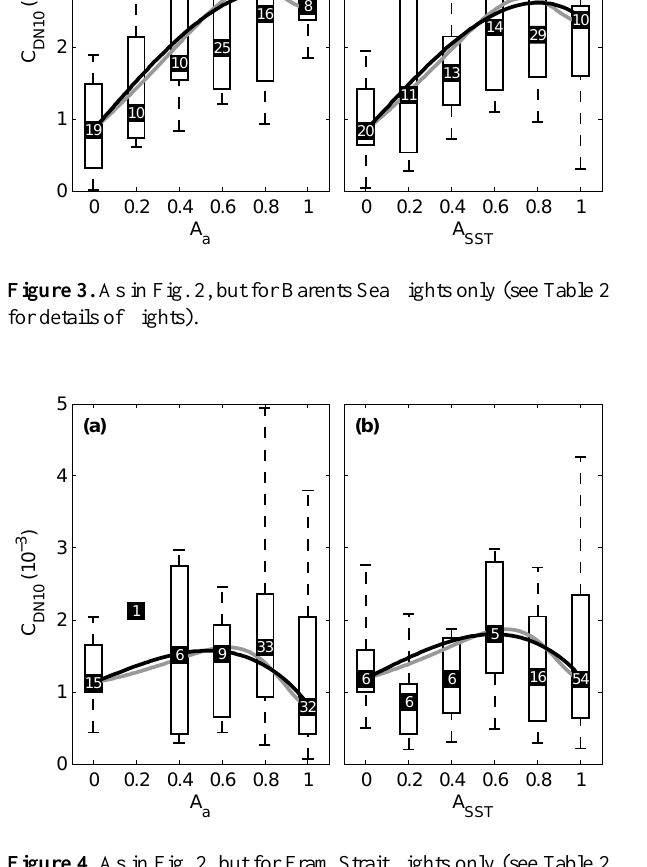
Figure 4. As in Fig. 2, but for Fram Strait flights only (see Table 2 for details of flights).